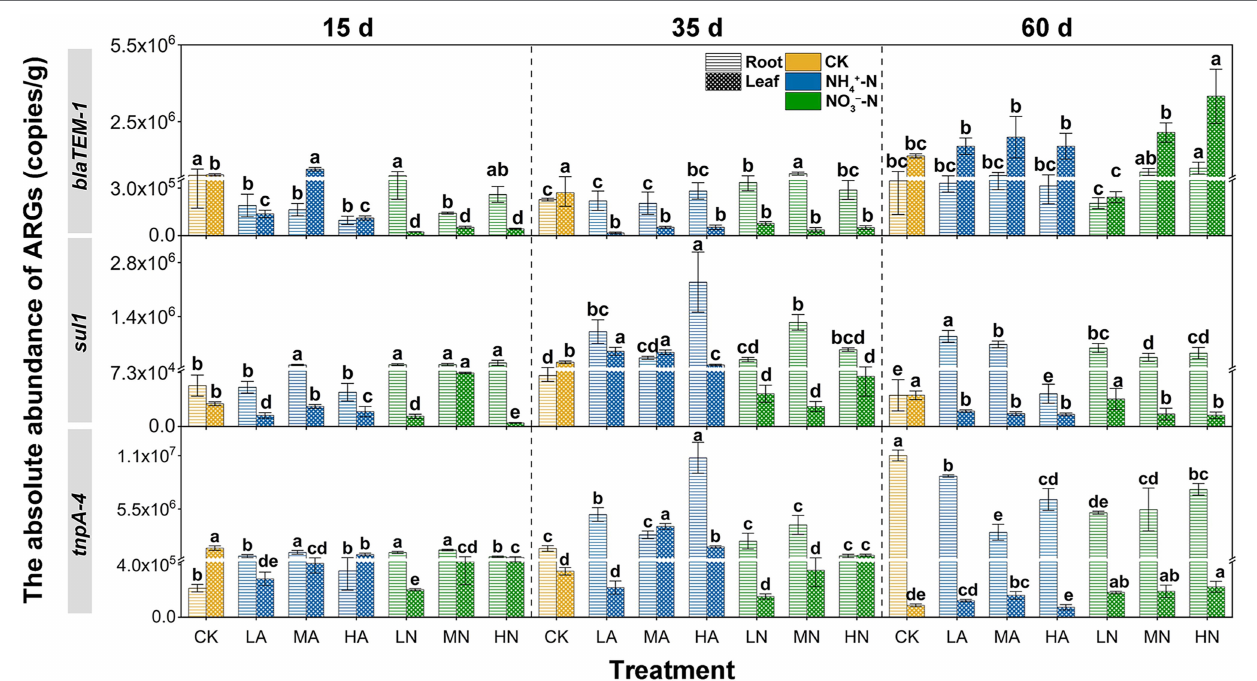
FIGURE 3 | The absolute abundance of ARGs ( blaTEM-1 , sull , and tnpA-4 ) in Chinese cabbage (roots and leaves) at three periods (15, 35, and 60 days) under different treatments: no nitrogen (CK), 25 mg kg − 1 NH 4+ -N (LA), 100 mg kg − 1 NH 4+ -N (MA), 200 mg kg − 1 NH 4+ -N (HA), 25 mg kg − 1 NO 3 − -N (LN), 100 mg kg − 1 NO 3 − -N (MN), and 200 mg kg − 1 (HN). Errors bars represent standard deviations of triplicate samples. Different lowercase letters above the bars indicated significant differences among treatments at p <